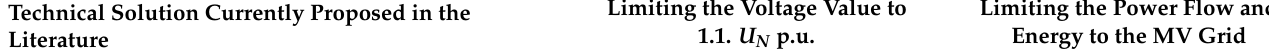
Table 6. Comparison of the functionalities of the technologies with potentially feasible application. Limiting the Voltage Value to Limiting the Power Flow and Energy to the MV